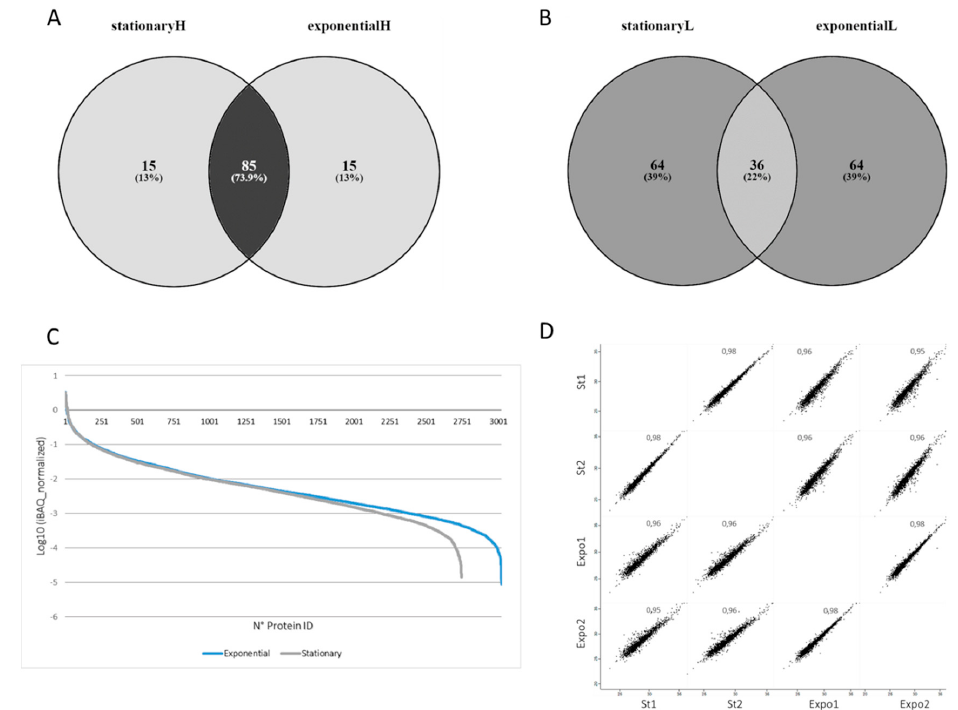
Figure 3. Proteome coverage and expression in the T. cruzi exponential and stationary phases. ( A ) intensity-based absolute quantification (iBAQ) values for the top 100 most abundant and ( B ) lowest abundant proteins identified in the stationary and exponential phases, H and L, respectively. iBAQ values were derived from LC-MS/MS values using the MaxQuant computational platform. ( C ) Normalized iBAQ values for the proteins identified and quantified in the exponential and stationary phases. Normalized iBAQ values were obtained by dividing each value for the total iBAQ in each biological replicate and averaging the two values. ( D ) Pearson correlation profile between the quantified proteins identified in the two biological replicates of the exponential (Expo1 and Expo2) and stationary phases (St1 and St2).